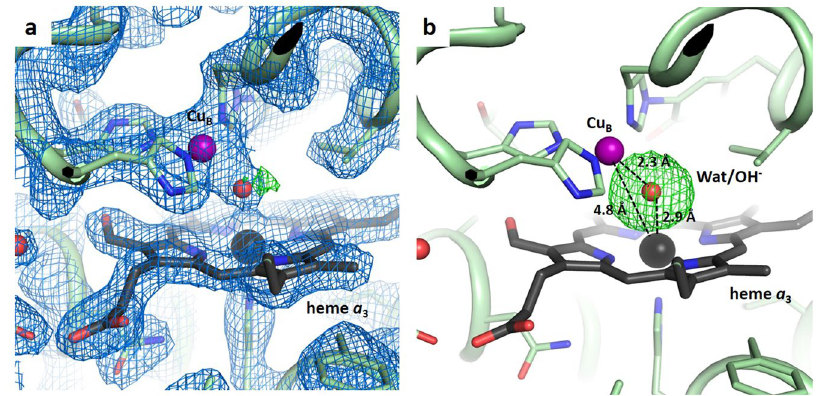
Figure 3. Active site structure of the ba 3 C c O from SFX data. ( a ) View of the heme a 3 – Cu B active site with a water molecule or hydroxide ion bound. The 2F o -F c density (blue) is contoured at 1.5 σ and the F o -F c difference density (green) at 4.0 σ . ( b ) The F o -F c omit map density, calculated without the water molecule, is contoured at